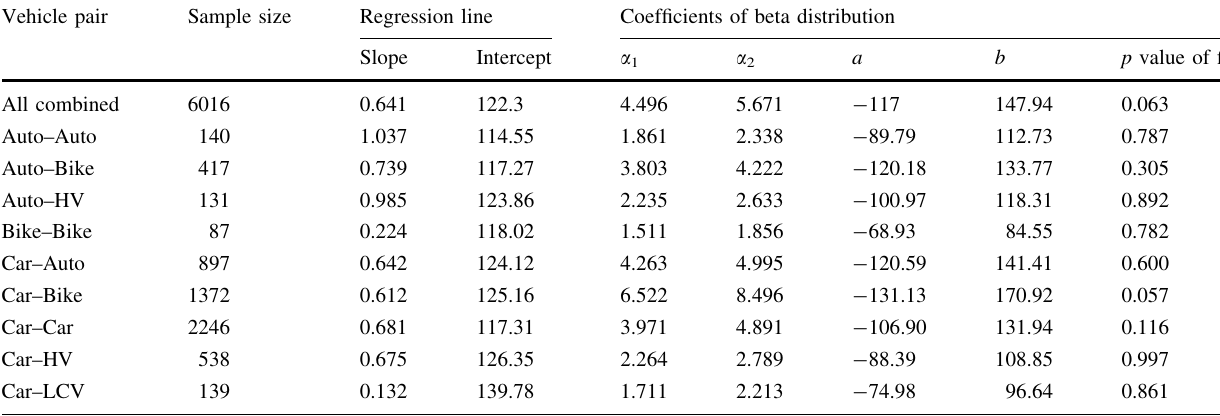
Table 4 Model parameter estimation for different vehicle